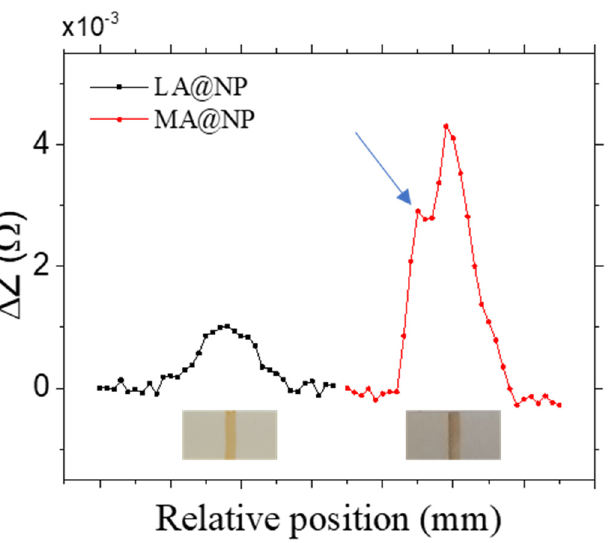
Figure 7. Test line sensor evaluation for the LFAs using LA@NP (black) and MA@NP (red) with 2 mg/mL neutravidin. The horizontal ticks represent 1 mm displacement steps. Bottom: Photographs of both LFAs. The blue arrow points at the peak corresponding to the particle accumulation in the LA@NP. For sample OA@NP, this behavior is also patent for a neutravidin concentration of 1 mg/mL, and hence, the only valid LFA is the one with the lowest concentration, 0.75 mg/mL (for this concentration, the number of large particles is small and not evident in the number-weighted size distribution.) In this case, the excessive agglomeration is likely to be caused by cross-linking among the preexisting agglomerates.